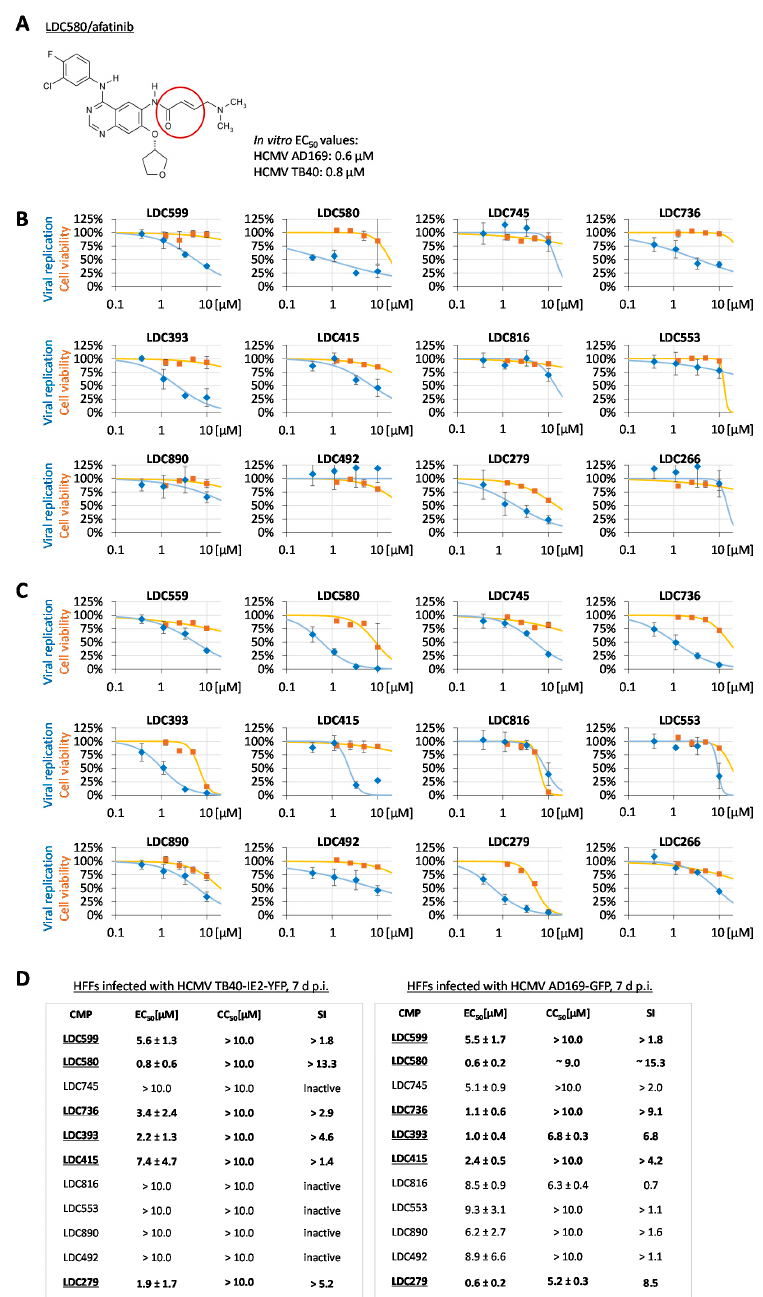
Figure 1. Anti-HCMV activity of investigational warhead compounds, including the clinical proto- type afatinib. ( A ) Chemical structure of a clinically approved prototype of covalently binding warhead inhibitors, LDC580, afatinib/Gilotrif ® . The red circle identifies a functionally active α -, β -unsaturated carbonyl group. ( B ) At 7 d p.i., compounds were analyzed for their cytotoxi- city (orange) and antiviral activity (blue) during HCMV infection, using TB40-IE2-YFP as a reporter virus. Cell viability was assessed through Neutral Red staining of uninfected cells. Measurements were performed in quadruplicate (YFP fluorometry) or triplicate (Neutral Red assay), and standard deviations of mean values are given; EC 50 , CC 50 and SI values are indicated accordingly. ( C ) In a parallel series of analyses, HCMV AD169-GFP was used as another reporter virus representing a second viral strain. The conditions of the antiviral assessment were identical to those for panel B. ( D ) Comparison of compounds analyzed against the two strains of HCMV: hit compounds with antiviral activity against both viral strains are marked as underlined in